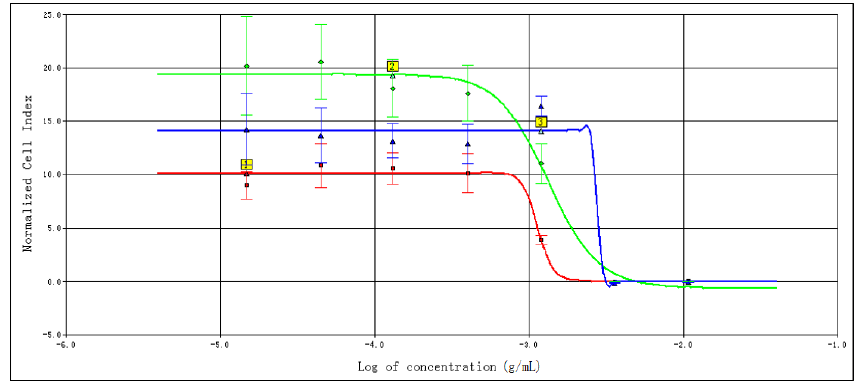
Figure 2. The 50% inhibitory concentration (IC50) calculation curve of MDA-MB-231 cells at the following time points: 24 h (red), 48 h (green), and 72 h (blue).